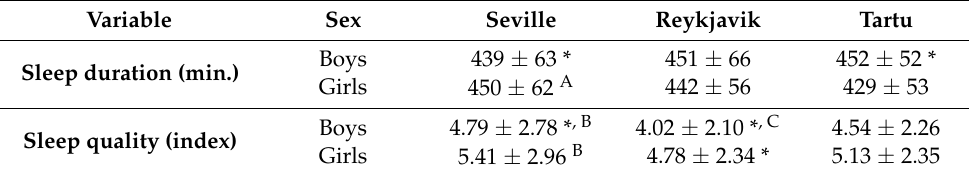
Table 2. Sleep duration and sleep quality in boys and girls in the three cities. Variable Sex Seville Reykjavik Tartu Sleep duration